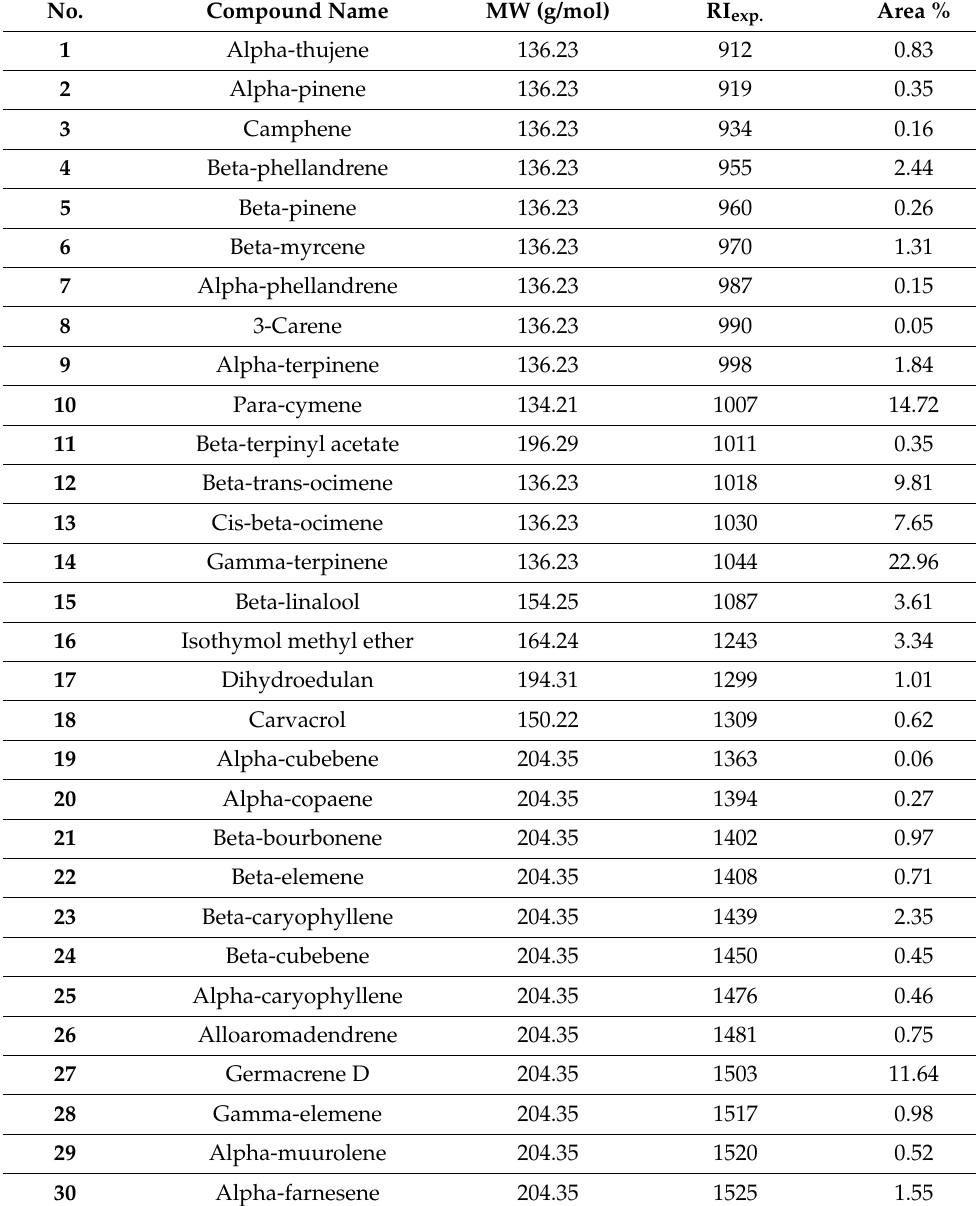
Table 2. Chemical composition of OEO as determined by GC-MS